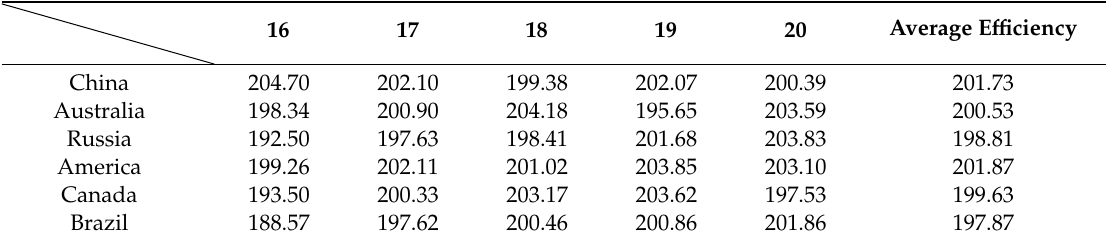
Table 4. Discretization e ffi ciency (number of cells rasterized ms − 1 ) of the spherical vector lines using the proposed index arithmetic.